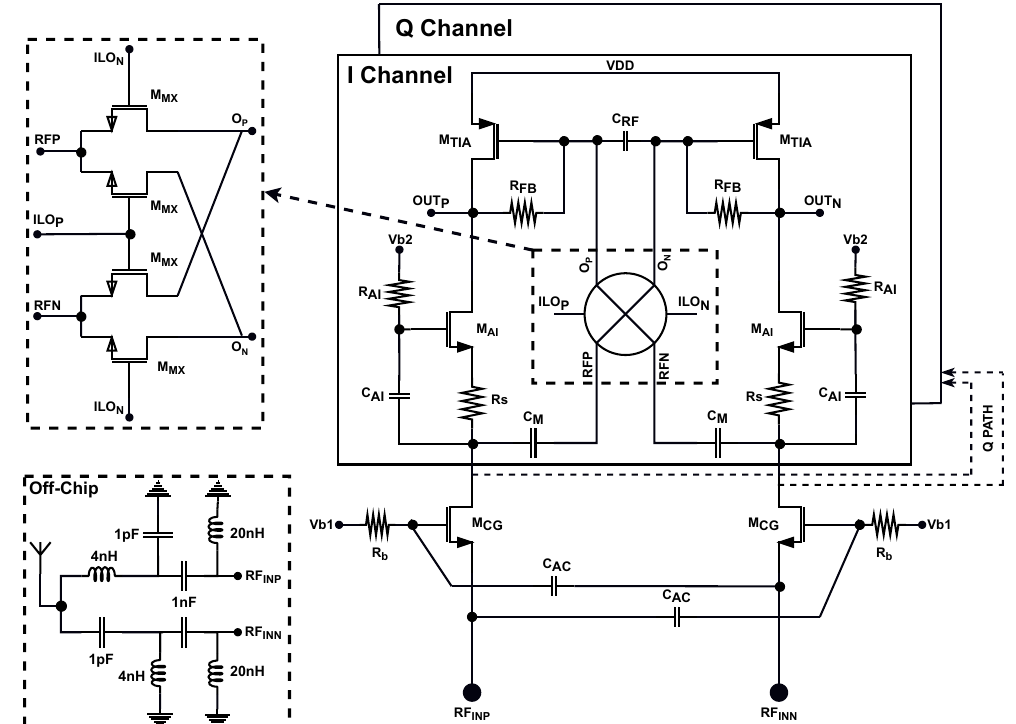
Figure 1. Block diagram of the proposed current-reuse receiver. Adapted with permission from Ref. [12]. Copyright 2022 Frederic